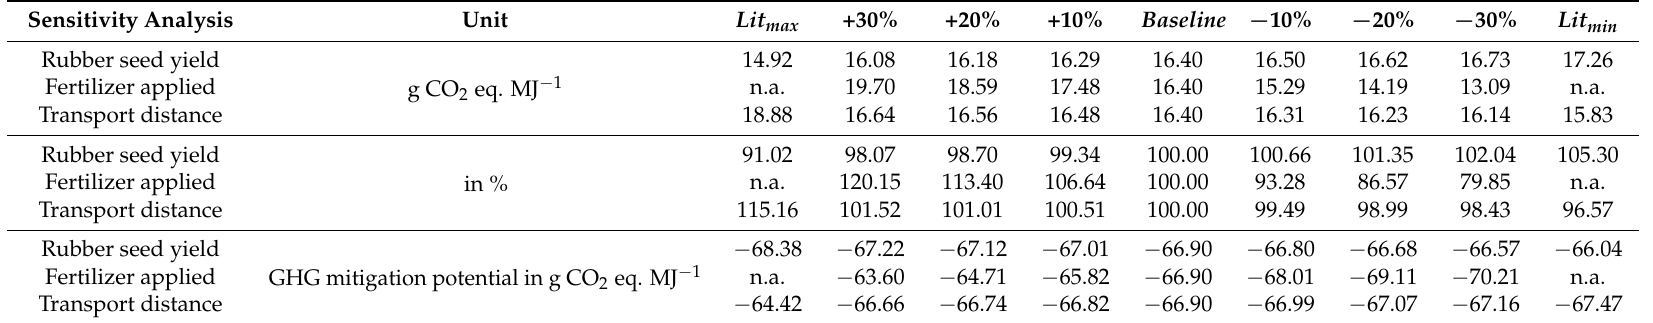
Table 6. Results of sensitivity analysis assessing the influence of variations in rubber seed yield, amount of fertilizer applied and transport distance on GHG emissions and GHG mitigation